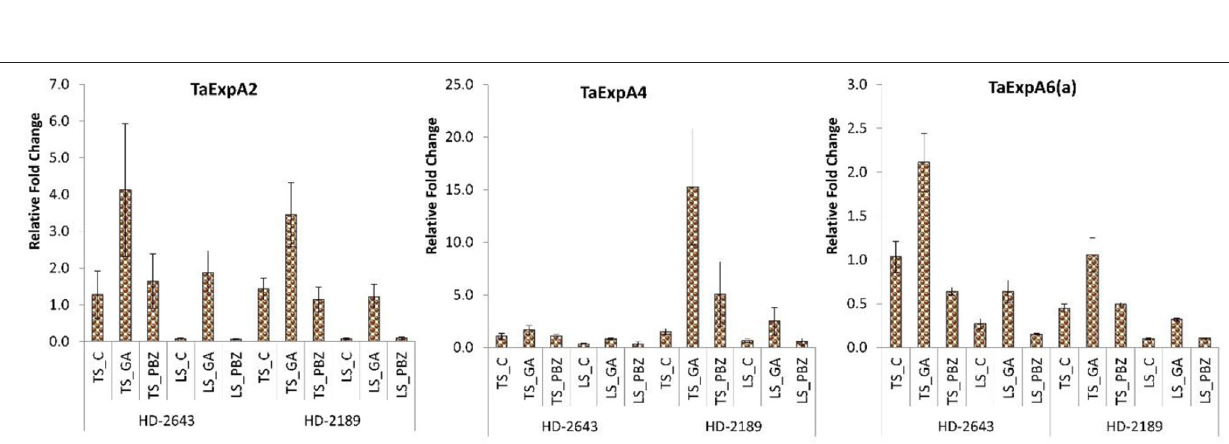
Frontiers in Plant Science |